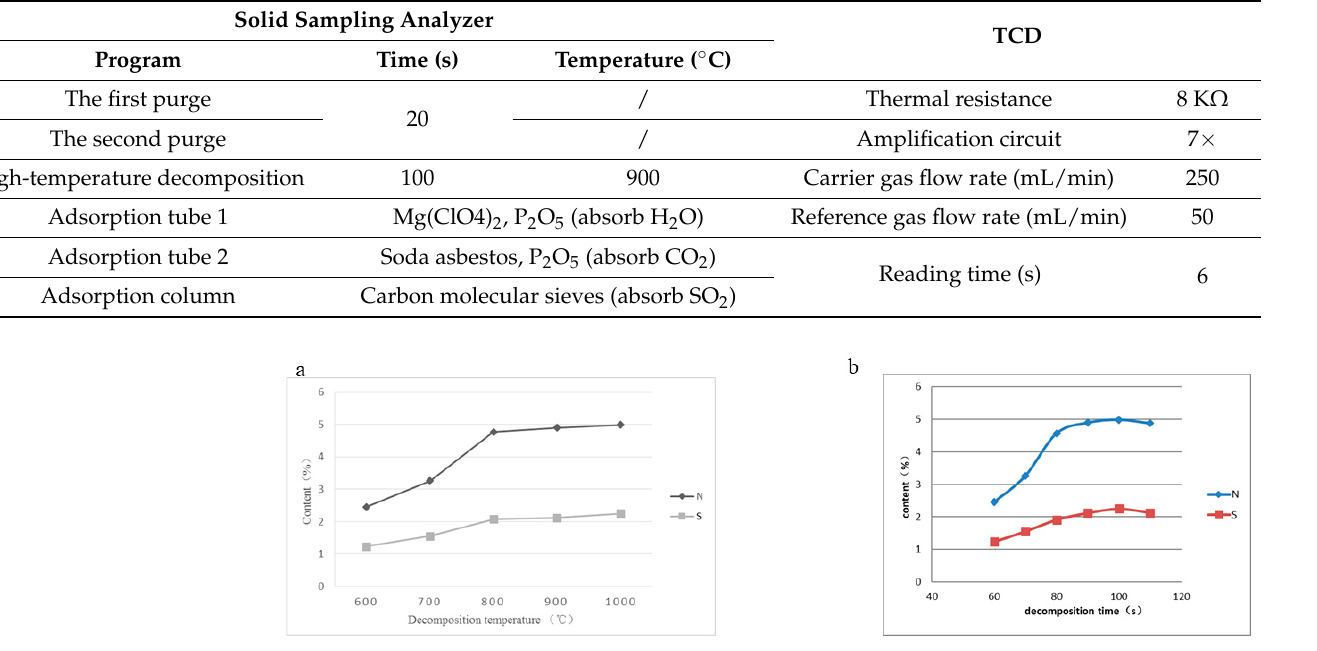
Table 1. Instrumental program of solid sampling system.